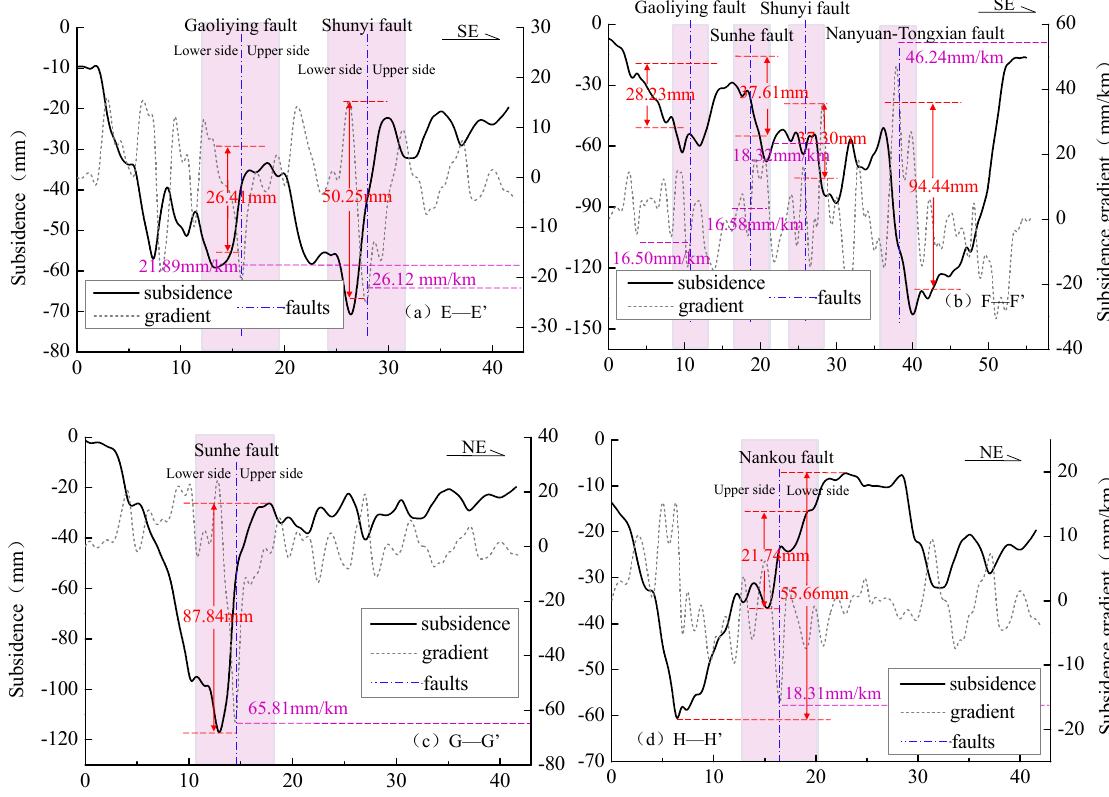
Figure 11. Differential land subsidence characteristics and deformation gradients on both sides of the fault. ( a ) Section E-E’. ( b ) Section F-F’. ( c ) Section G-G’. ( d ) Section